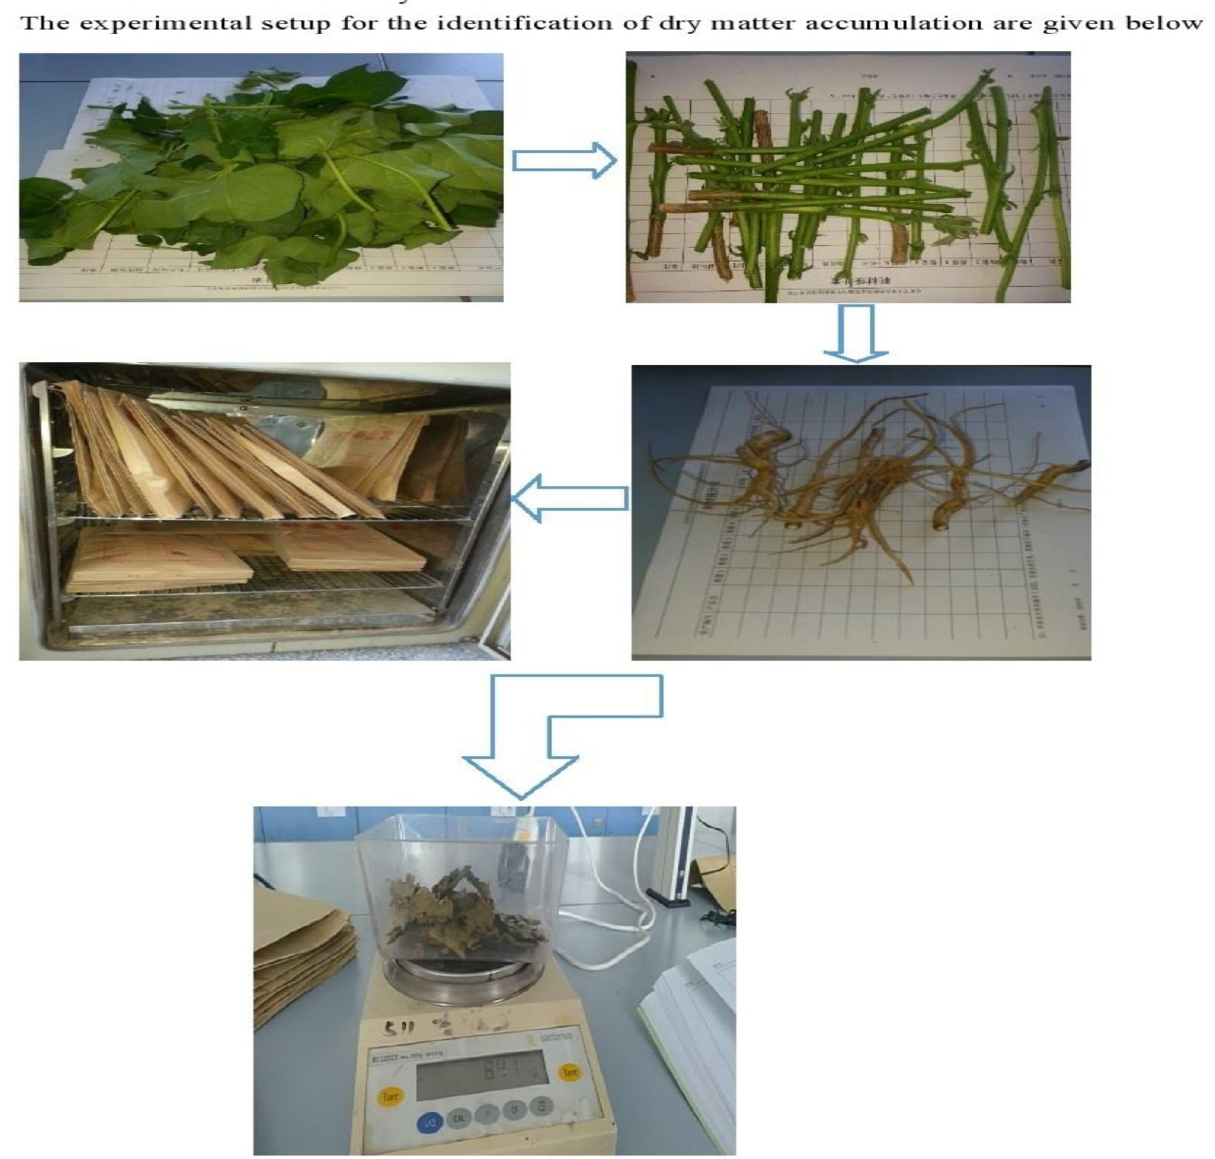
Fig 1. Schematic of dry matter accumulation